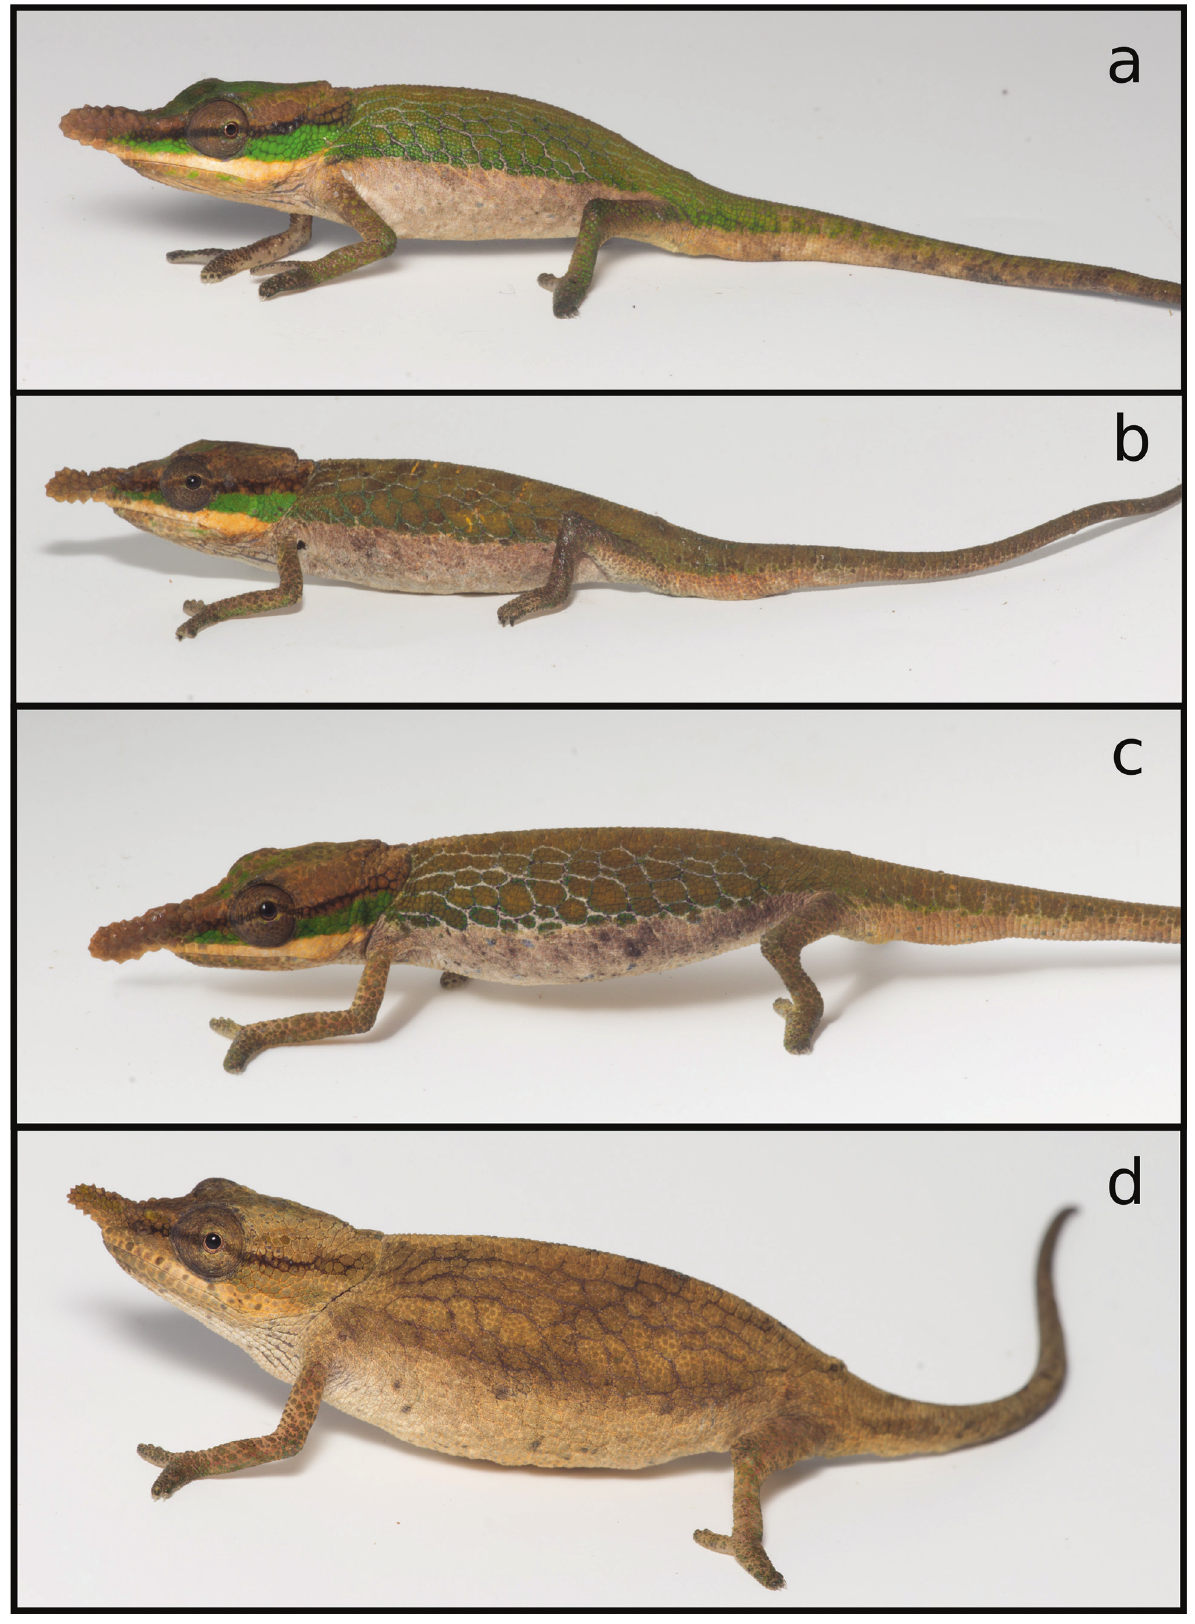
Figure 5. In-life photos of four specimens of Calumma roaloko sp. n.; ( a ) subadult male (ZSM 244/2018, KU 343177); ( b ) the holotype, adult male (KU 343178); ( c ) subadult male (UADBA-R, KU 343167); ( d ) adult female (KU